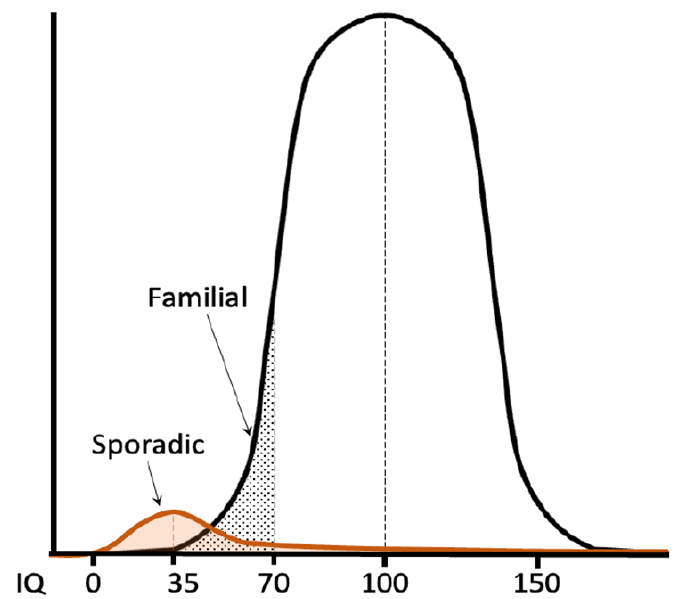
Figure 1. The IQ distribution of the “ normal ” population has the shape of a Gaussian curve, with the mean IQ set at 100 IQ points. IQ scores below 70 are observed in ~2.5% of the population. The second curve with the mean around 35 IQ points represents individuals with a pathophysiological cause underlying low IQ measurements (adapted from Zigler et al., 1967 [7]).